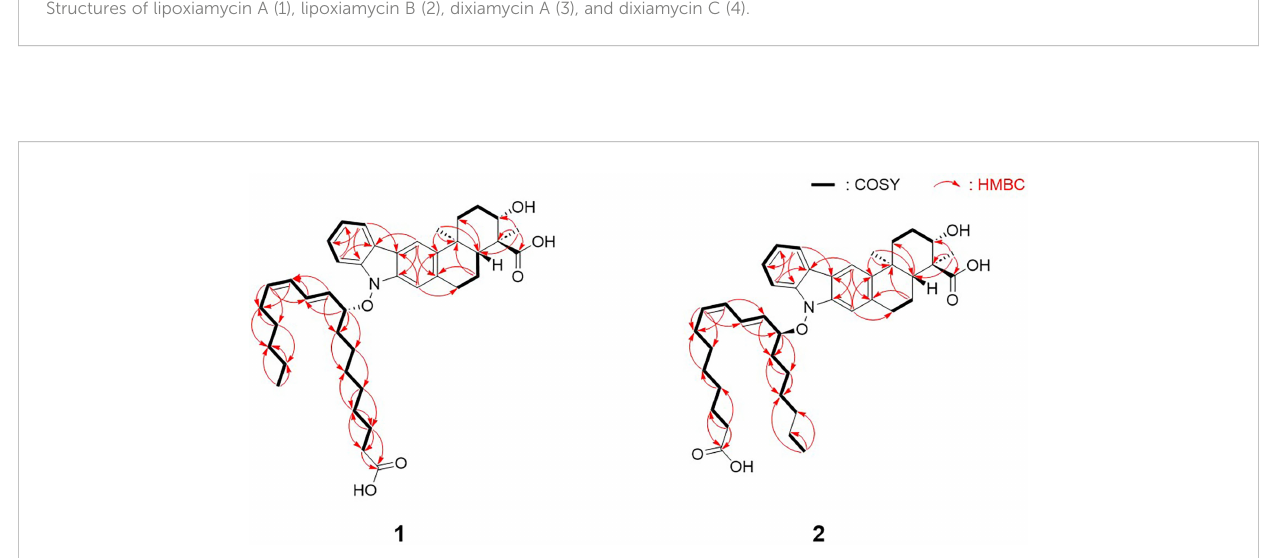
FIGURE 2 Key COSY and HMBC correlations of lipoxiamycins A (1) and B (2).